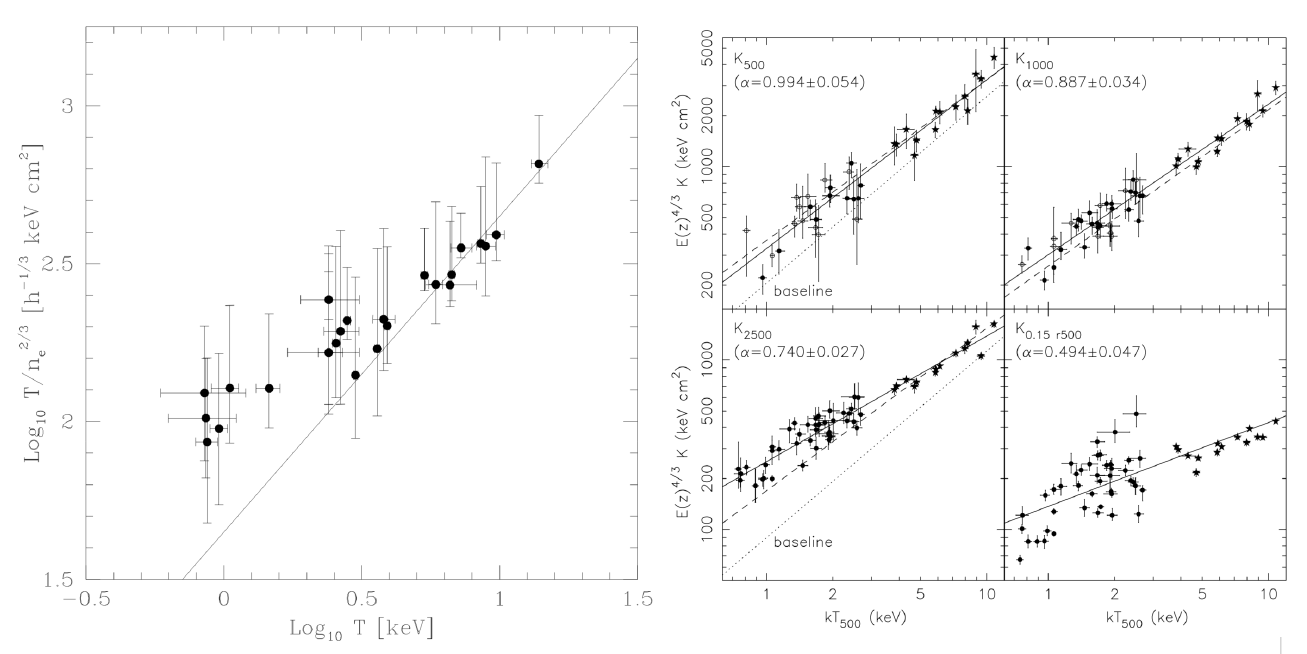
Figure 5. Left : The gas entropy at the fiducial radius of 0.1 R virial as a function of the temperature for the 25 systems in the sample of Ponman et al. [134]. The solid line shows the relation obtained from numerical non-radiative simulations [136]. Figure reproduced from Ponman et al. [134], arXiv author’s version. Right : The same relation at different radii for the groups analyzed in the sample of Sun et al. [137], together with the sample of clusters in Vikhlinin et al. [138], both being analyzed with Chandra data. Figure reproduced from Sun et al.